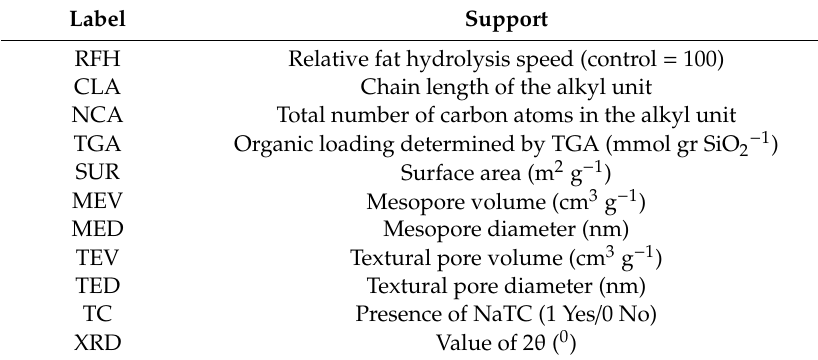
Table 2. List of labels used in the Partial Least Squares Regression (PLSR) model.